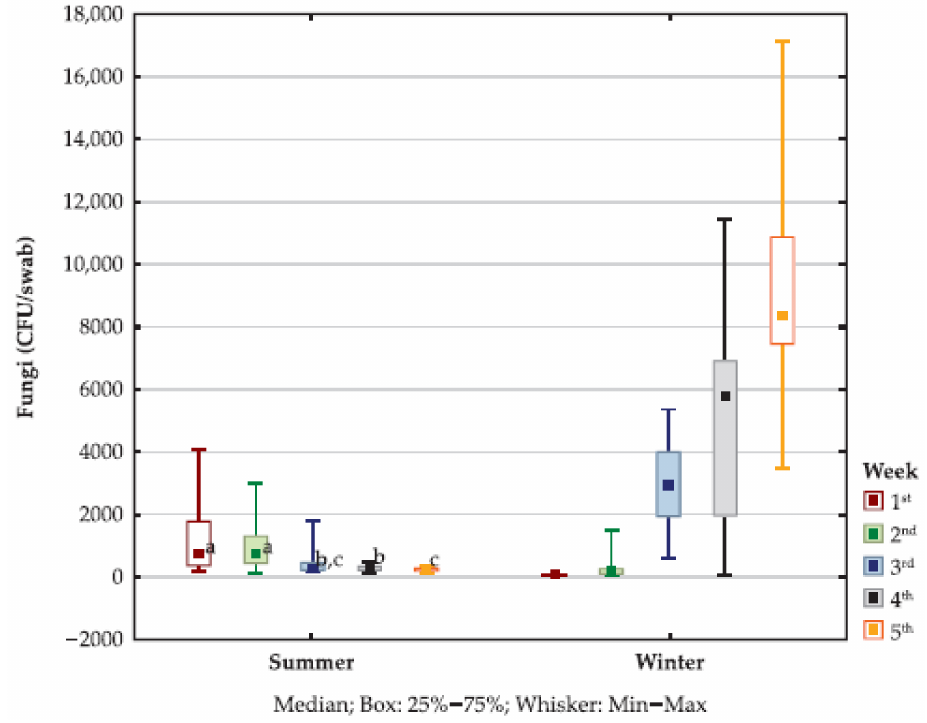
Figure 2. Tracheal fungi according to broiler fattening weeks in summer and winter. a,b,c All values within the same season differ significantly ( p < 0.05), except for those marked with the same letter. All values within the same weeks differ significantly between the seasons ( p <